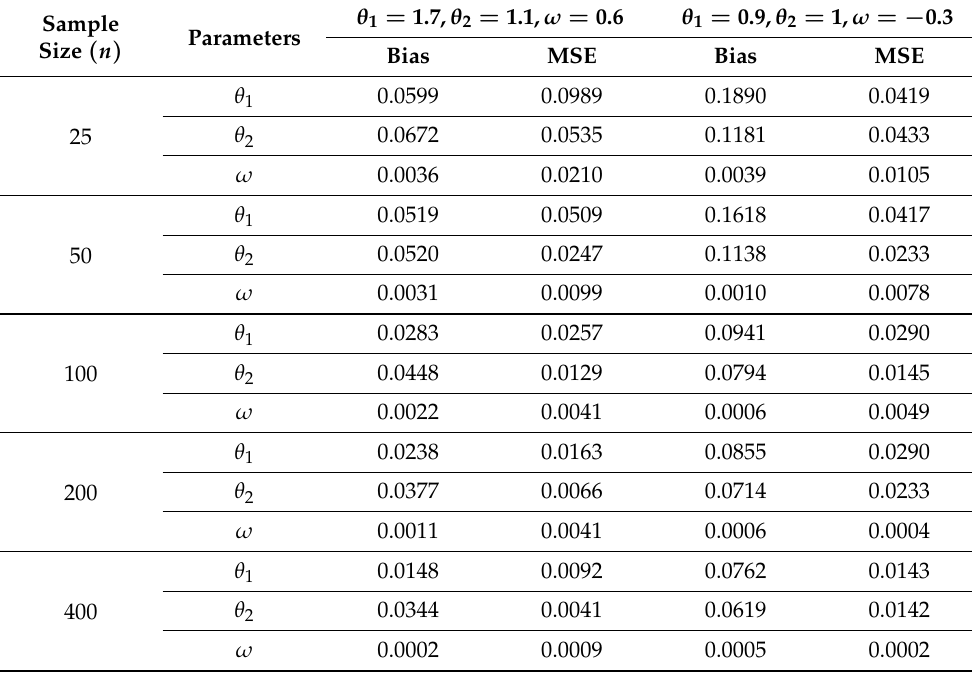
Table 2. Simulation results for the BP2S-L(II) distribution.